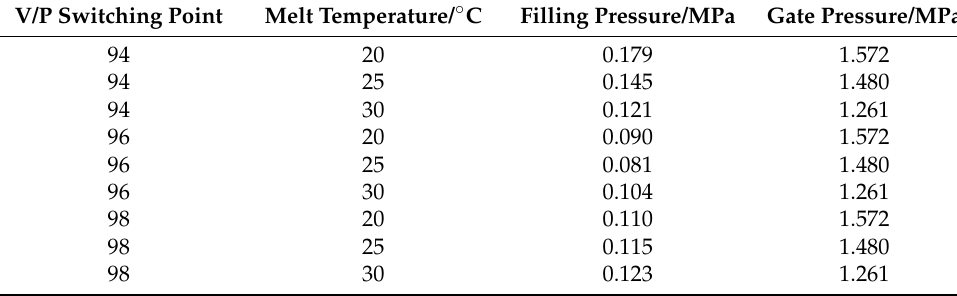
Table 4. Influence of pressure change at the